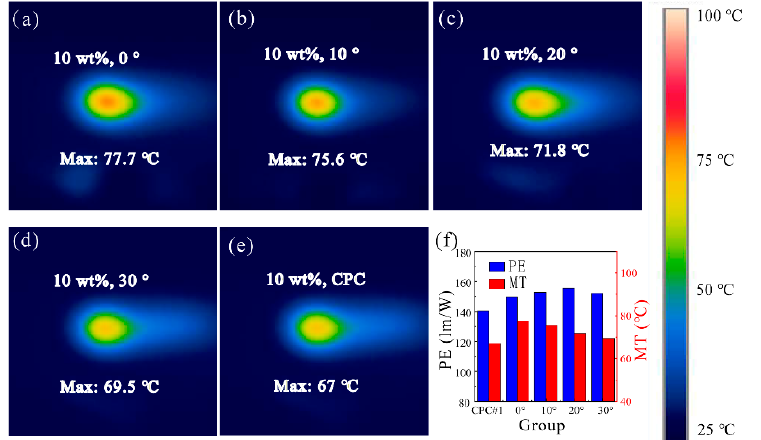
Figure 8. Temperature distribution of ATFPCs with ( a ) 10% concentration, 0°; ( b ) 10% concentration, 10°; ( c ) 10% concentration, 20°; ( d ) 10% concentration, 30° and the CPCs with ( e ) 10% concentration; and photoluminescence efficiency (PE) of ( f ) the ATFPCs as well as the CPCs, with the same thickness of 0.5 mm.